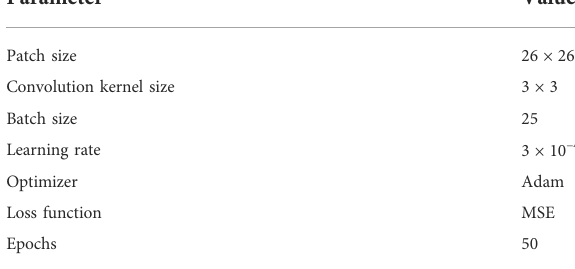
TABLE 1 Parameters setting of the